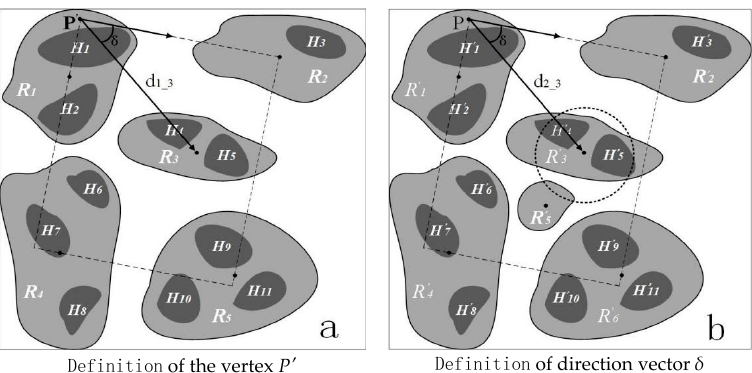
Figure 8. Buffer analysis determines the matching set.